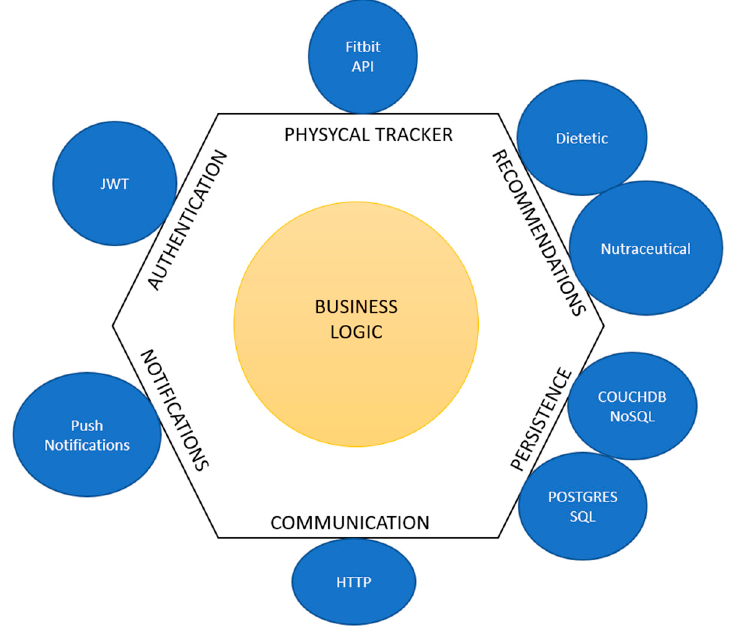
Figure 1. Adaptation of Cockburn’s hexagonal architecture to OBINTER approach.